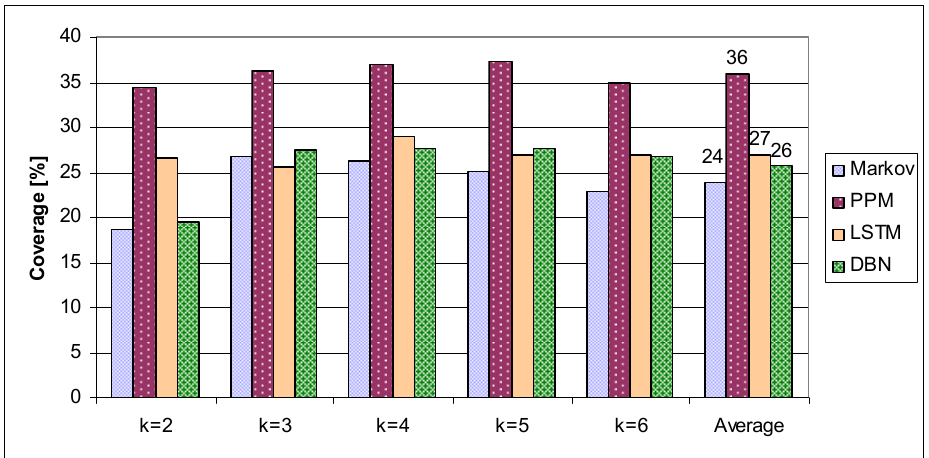
Figure 9. Coverage without the mood variable through k ‐ fold cross ‐ validation.